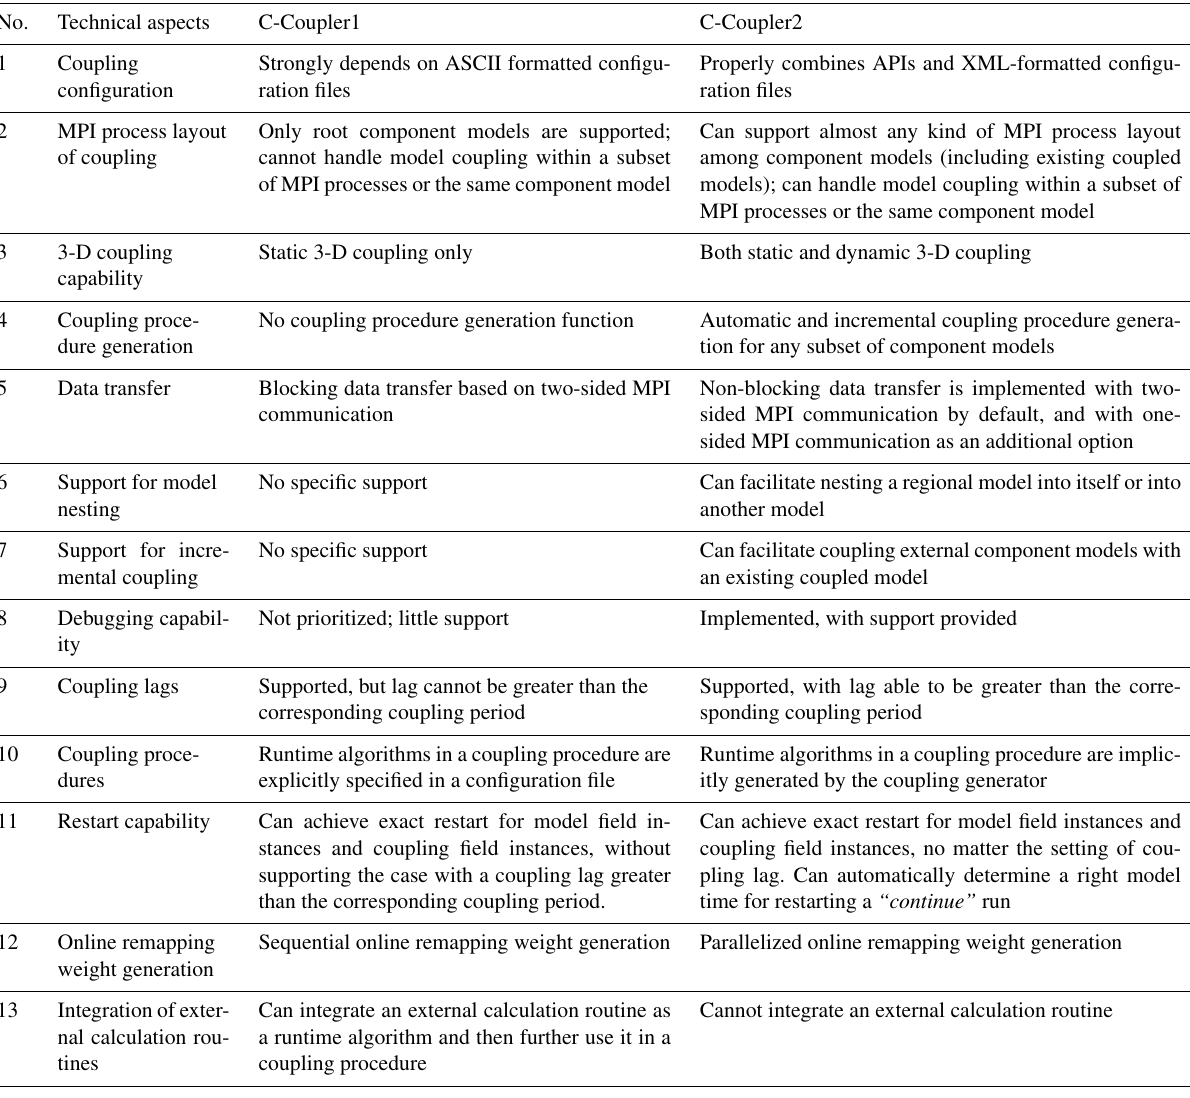
Table 2. Differences between C-Coupler1 and